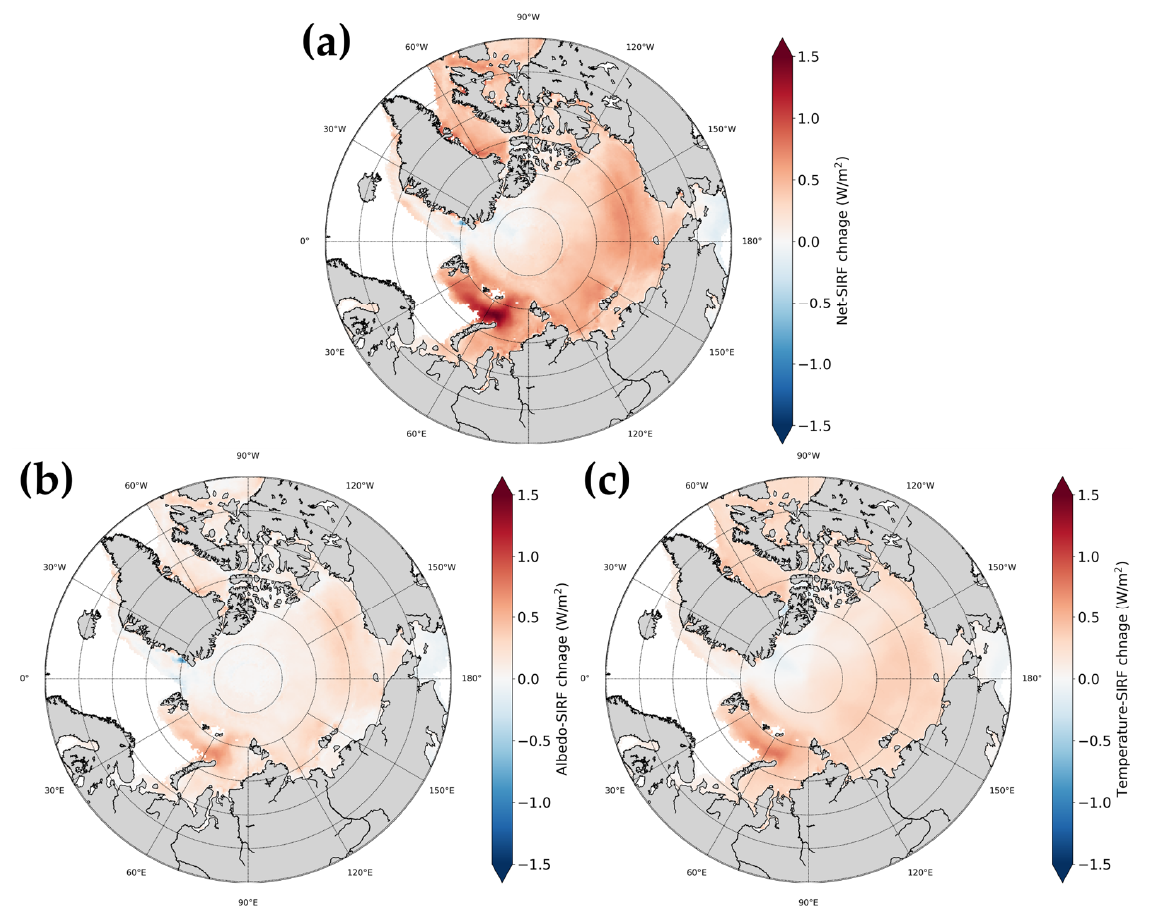
Figure 4. Spatial distribution of the annual change in SIRFs for each factor based on mean of five radiative kernels: ( a ) net-SIRF, ( b ) albedo-SIRF, ( c ) Table 2. SIRFs annual change according to region (W/m 2 ).